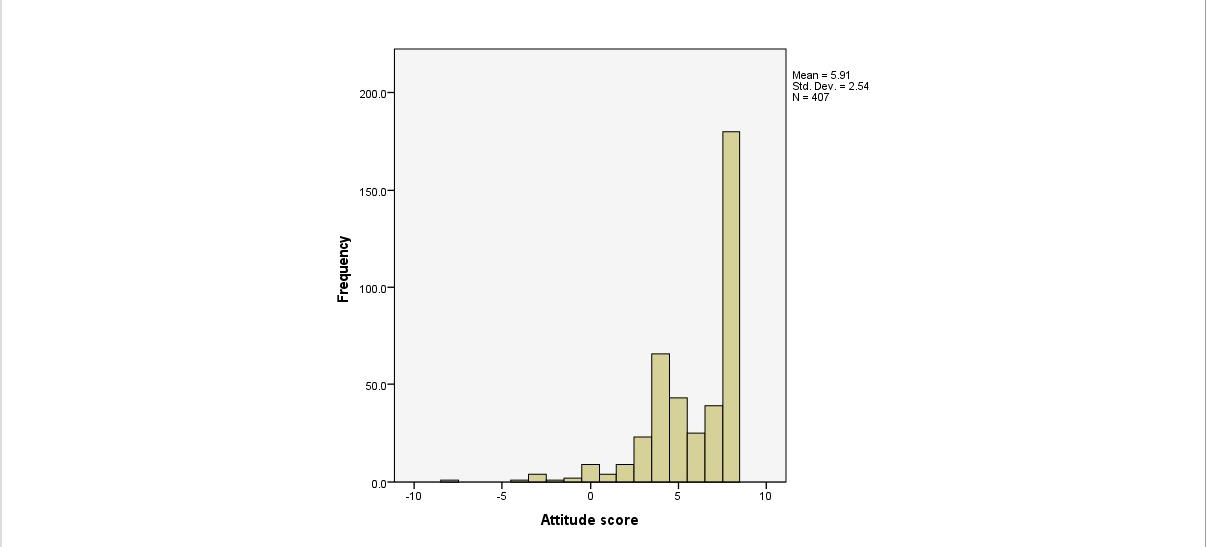
FIGURE 2 Beaver-related attitude frequency distribution for all survey participants.